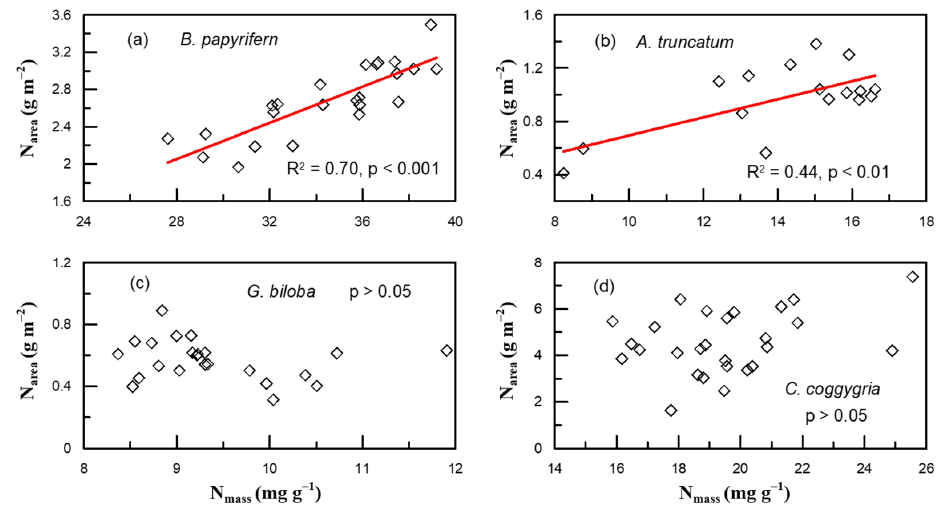
Figure A1. Relationship between leaf N based on area (N area ) and leaf N based on mass (N mass ) of four species derived from the second sampling campaign: ( a ) B. papyrifern , ( b ) A. truncatum , ( c ) G. biloba , ( d ) G. coggygria .